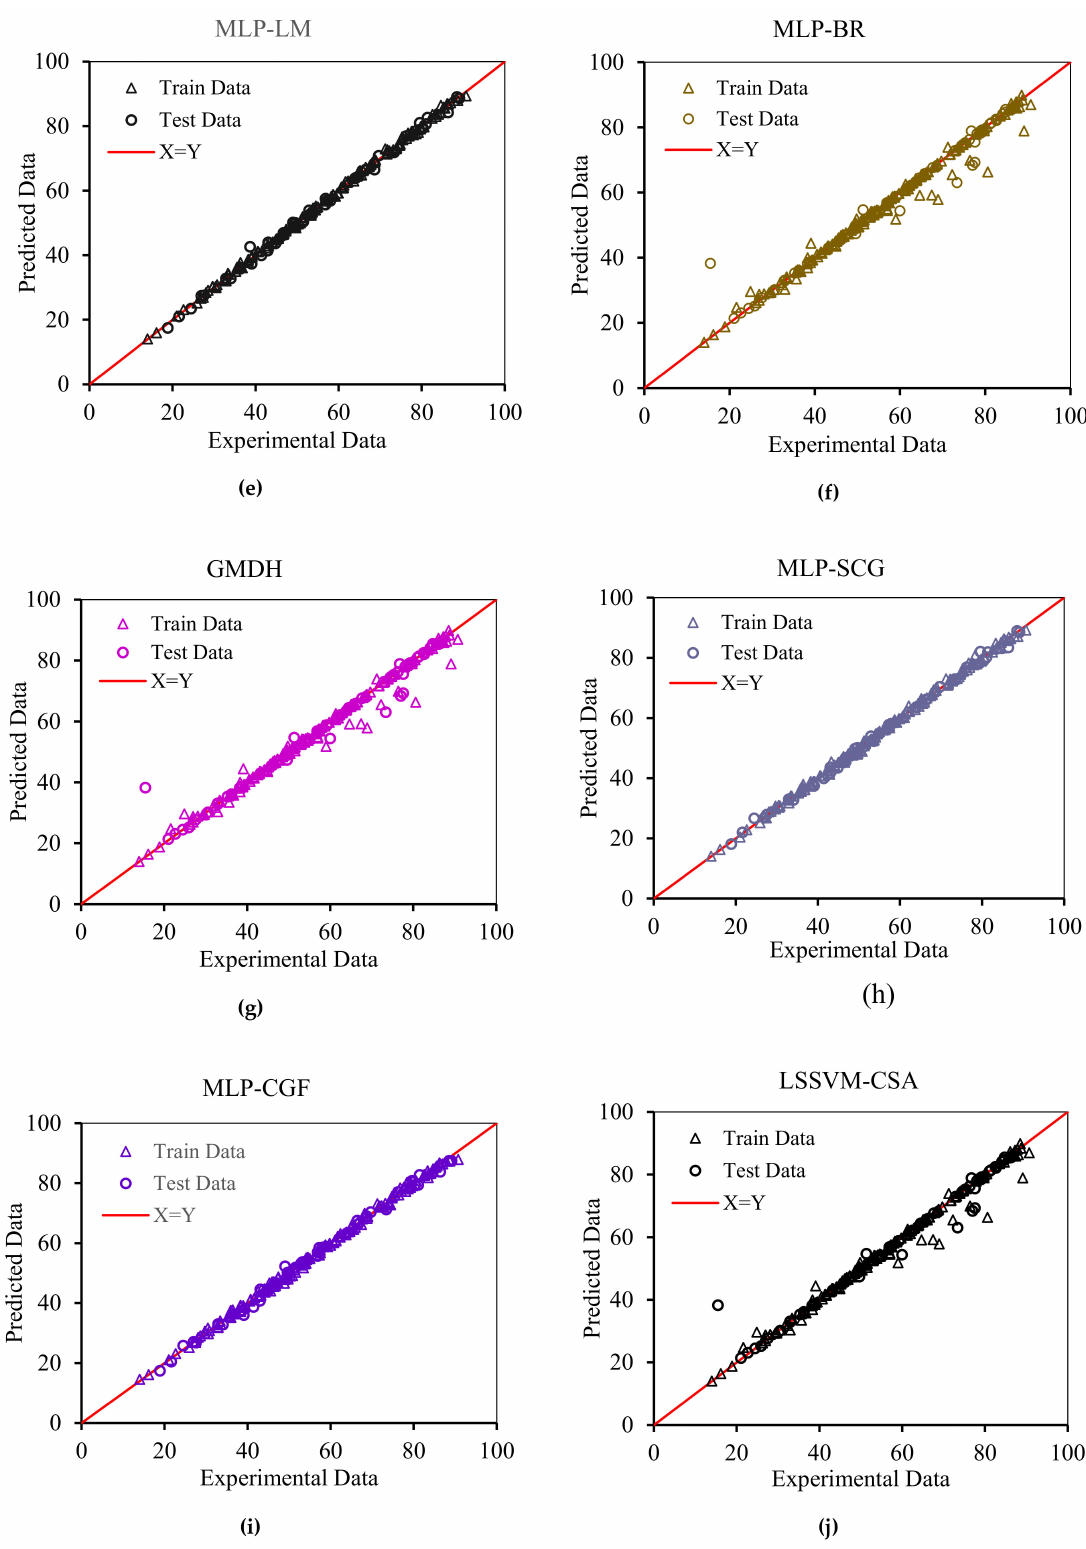
Figure 8. Cross plots for the asphaltenes adsorption models presented in this study for both training and testing subsets: ( a ) RBF-ACO, ( b ) RBF-PSO, ( c ) RBF-ICA, ( d ) RBF-GA, ( e ) MLP-LM, ( f )